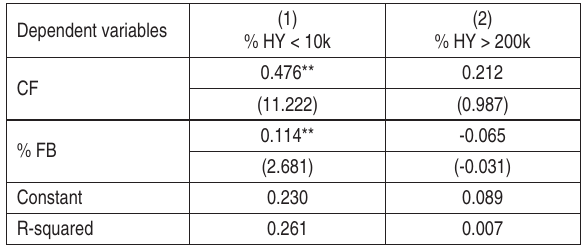
Table 4. Income inequality and the tails of